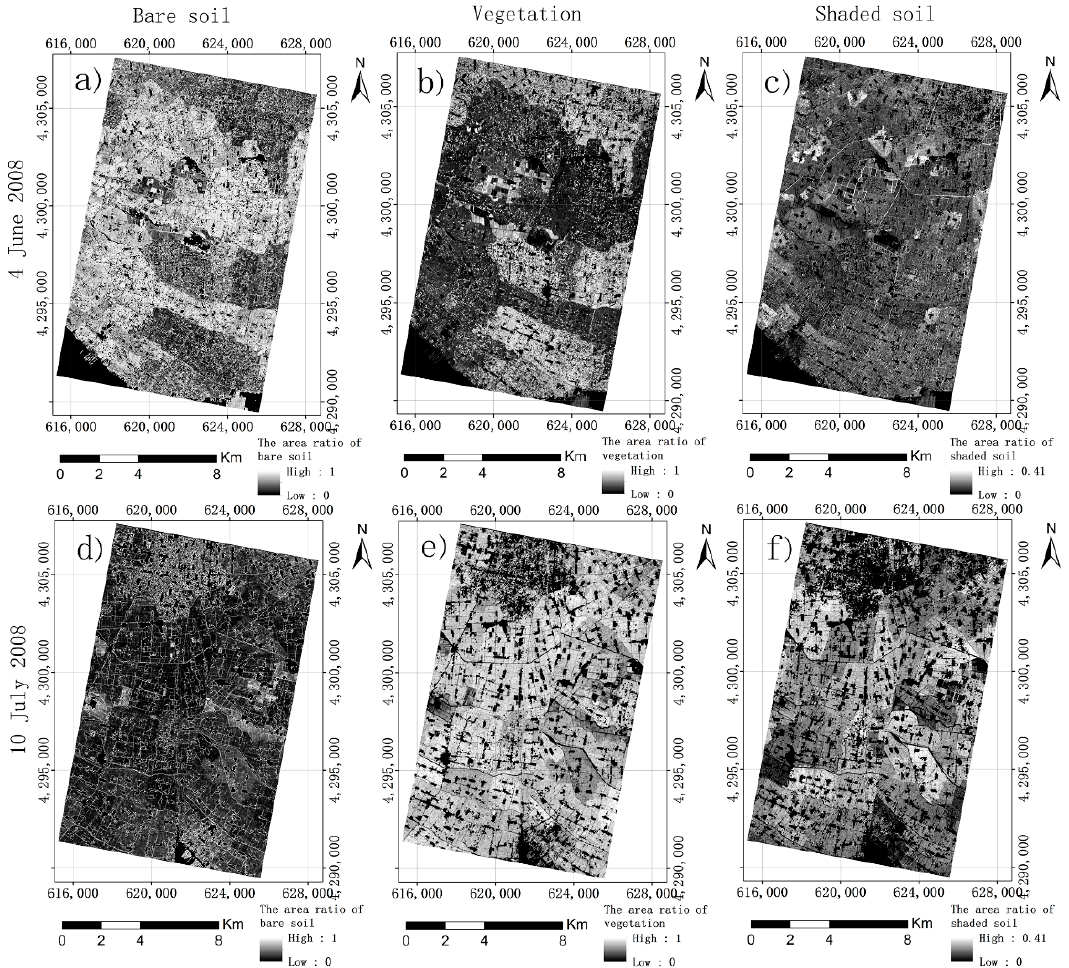
Figure 7. The area fraction maps of three components derived from ASTER data using a spectral unmixing analysis for the study area: ( a , d ) bare soil; ( b , e ) vegetation; and ( c , f ) shaded soil for the June unmixing analysis for the study area: ( a ) and ( d ) bare soil; ( b ) and ( e ) vegetation; and ( c ) and 4th and July 10th images of 2008, ( f ) shaded soil for the June 4 th and July 10 th images of 2008, respectively.